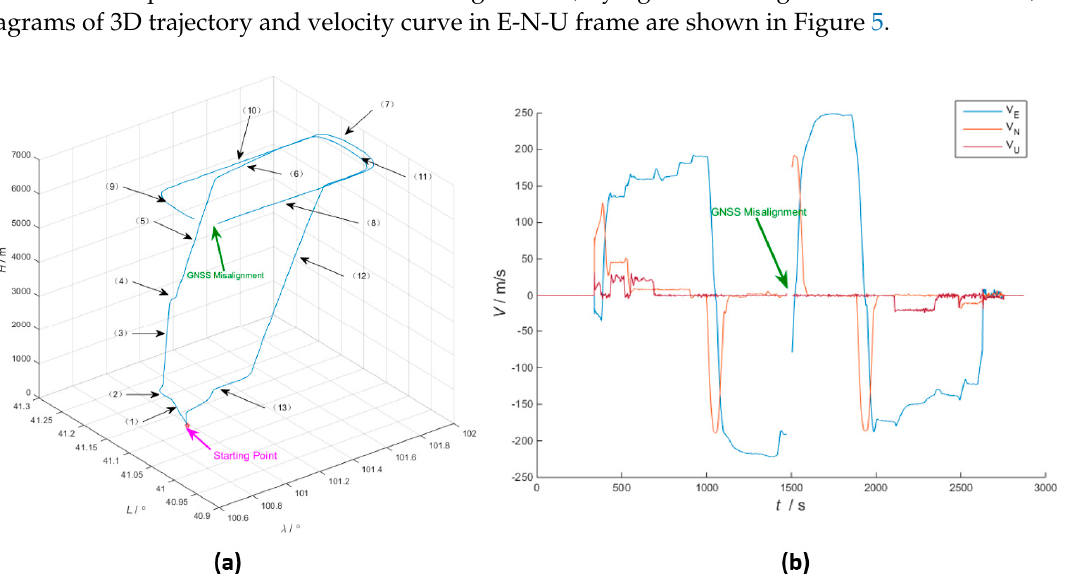
Figure 6. 3D trajectory diagram ( a ) SHAKF; ( b ) STF; ( c ) H ∞ filter; ( d ) SAKF.